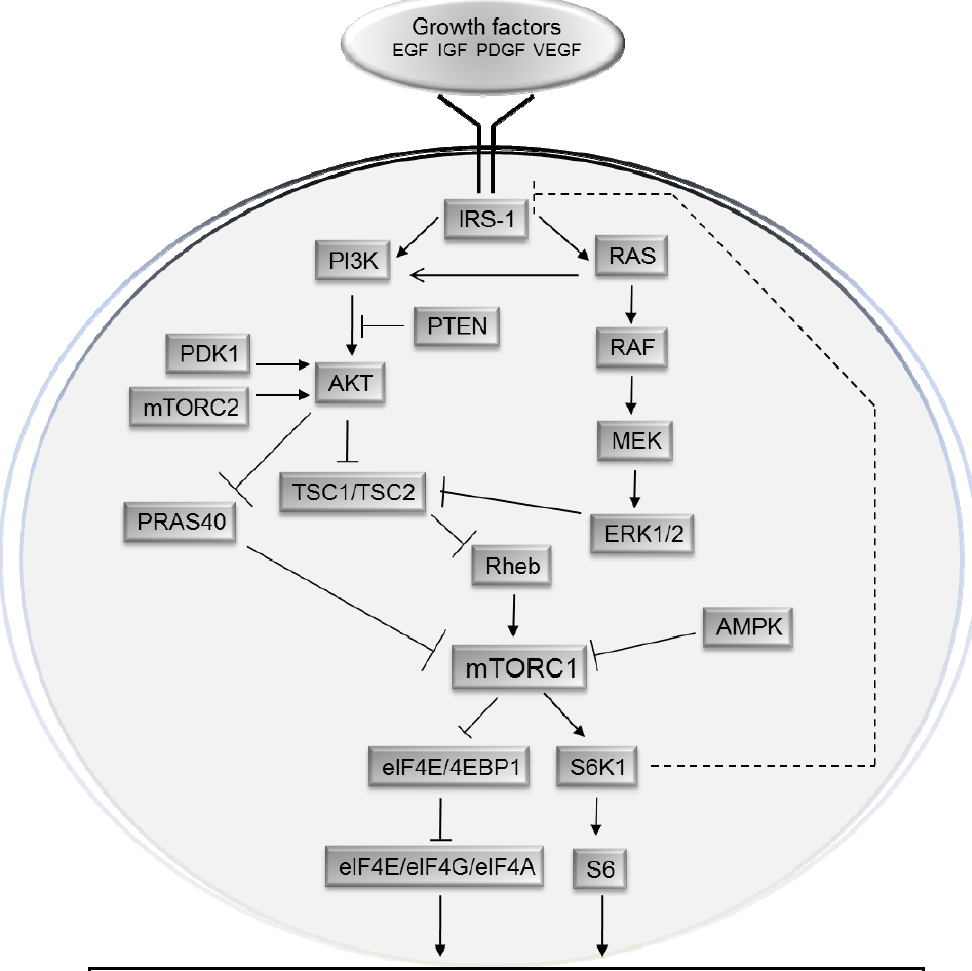
Figure 3. Diagram of the mTOR signalling pathway (see text for details). mTOR is a central regulator of cell growth and proliferation in response to environmental and nutritional conditions. The mTOR signalling pathway is regulated by growth factors, amino acids, and ATP and O levels. Signalling through mTOR modulates several downstream 2 pathways that regulate cell-cycle progression, translation initiation, transcriptional stress responses, protein stability, and survival of